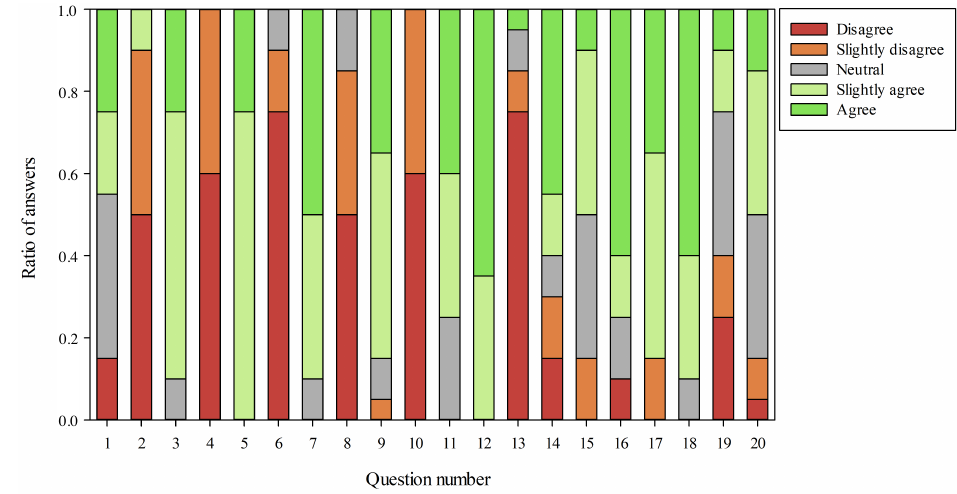
Figure 12. Results of survey indicating ratio of each answer for each